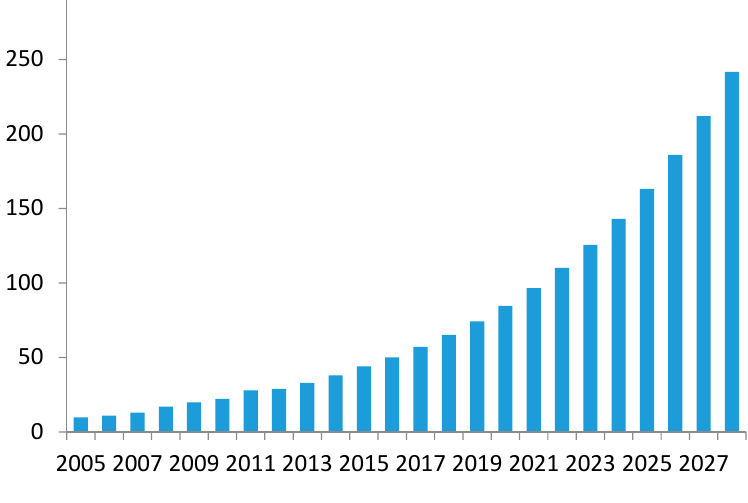
Figure 2. Drug spending per capita in